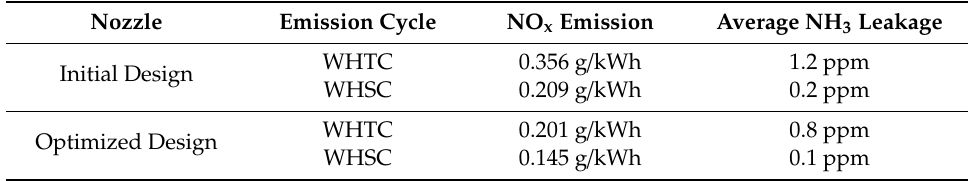
Table 6. WHSC and WHTC emission certification results.